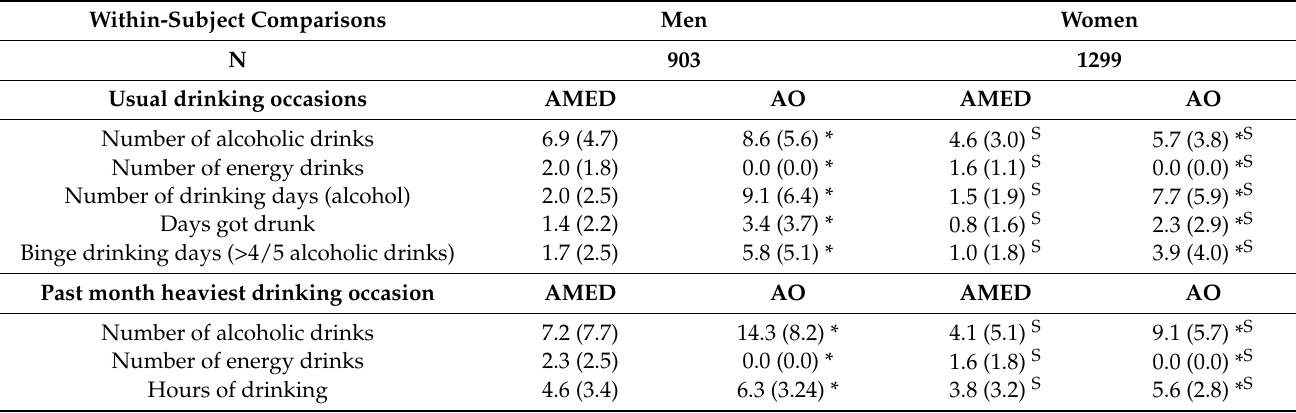
Table 10. Alcohol consumption of male and female AMED consumers on usual AMED and AO occasions (within-subject comparisons).